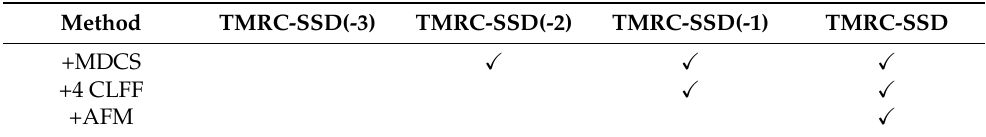
Table 6. Models with various designs.